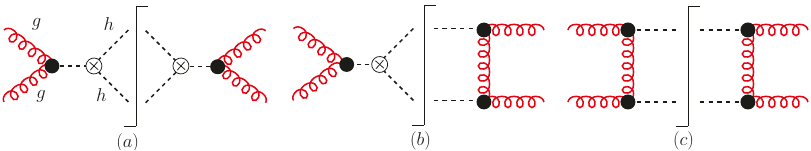
Figure 2 . Representative Born cut-diagrams for the Higgs boson pair production in the e(cid:11)ective theory. The cross section can be classi(cid:12)ed by the number of e(cid:11)ective vertices between the two Higgs bosons and gluons.